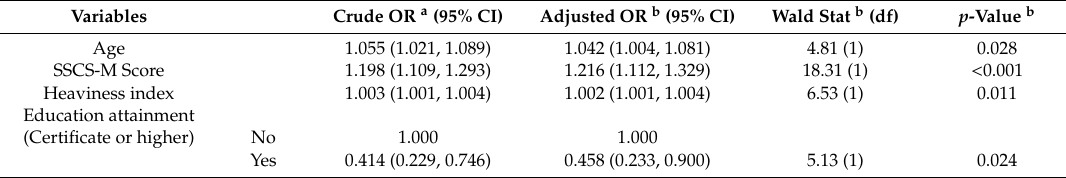
Table 6. Factors associated with positive smoker identity using multiple logistic